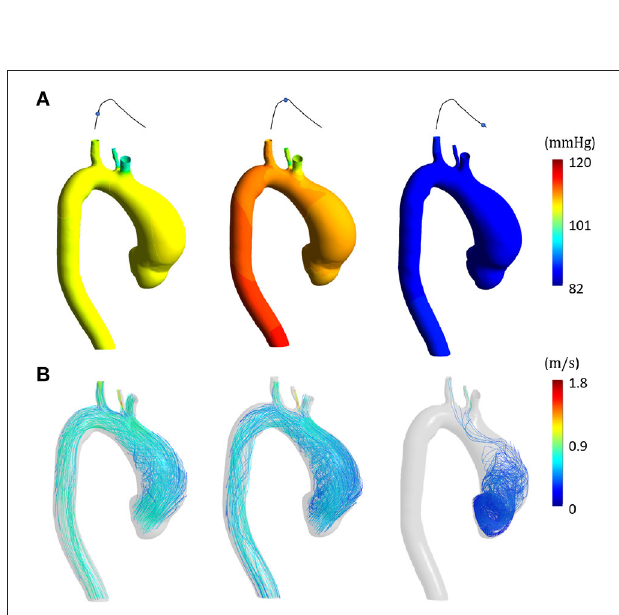
FIGURE 7 | Fluid dynamic results from non-linear FSI at early systole, peak systole and late diastole in terms of (A) pressure distribution and (B) velocity